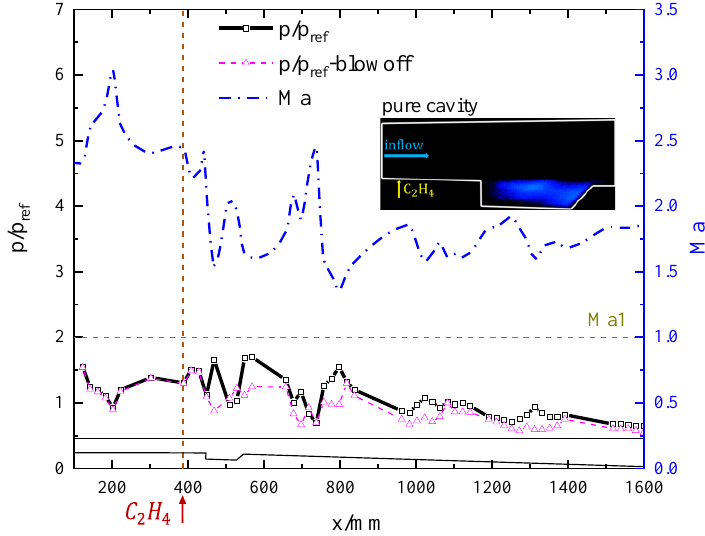
Figure 9. Dimensionless pressure/Mach number along x axis and mean pseudo-color image of CH* chemiluminescence at Case 5 (1.2D 0 II0.182).